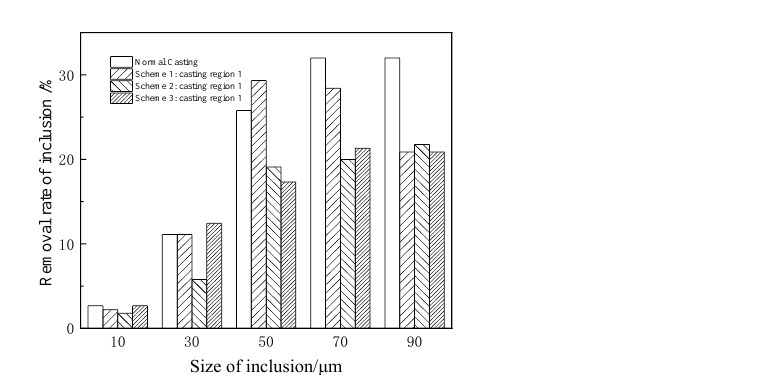
Figure 9. Removal rate of inclusion in fewer strands casting area of each scheme.